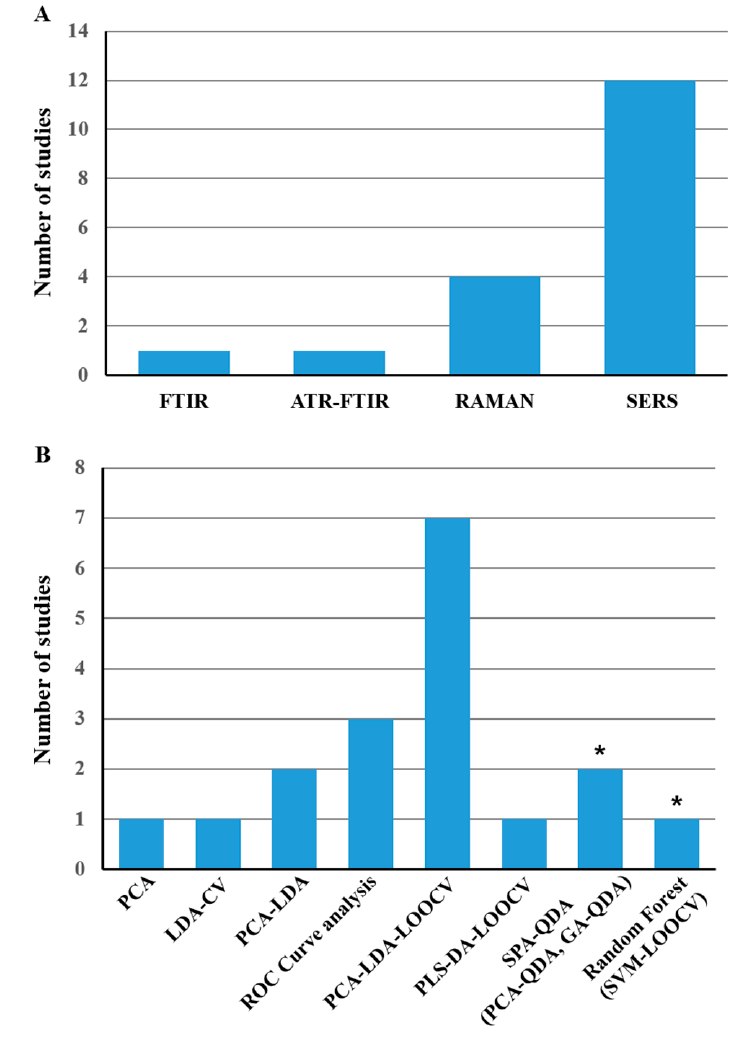
Figure 2. The number of studies, according to vibrational spectroscopy (VS) and algorithms techniques. ( A ) Vibrational spectroscopic techniques; ( B ) Algorithms used for data processing; * indicates results from the most relevant algorithm according to the authors; PCA, principal component analysis; LDA, linear discriminant analysis; LOOCV, leave-one-out cross-validation; SPA-QDA, successive projections algorithm quadratic discriminant analysis; GA-QDA, genetic algorithm quadratic discriminant analysis; PCA-QDA, principal component analysis quadratic discriminant analysis; SVM, support vector machine; PLS-DA, partial least squares discriminant analysis; ROC, receiver operating characteristics.